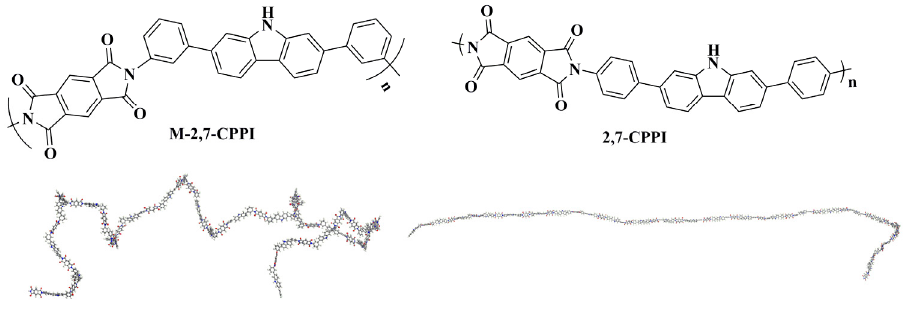
Figure 4. The polymer chain conformations of M-2,7-CPPI and 2,7-CPPI under the lowest energy.